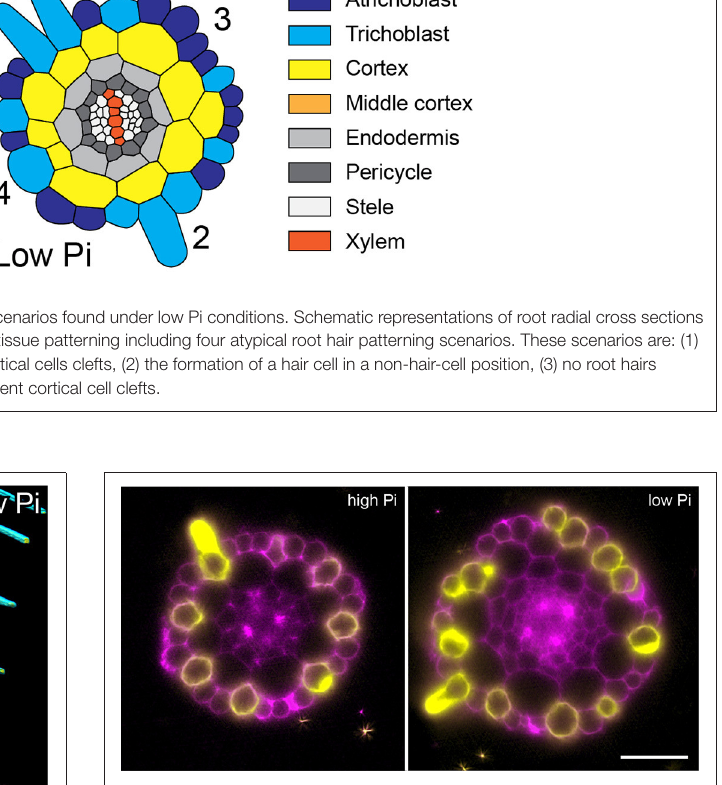
FIGURE 7 | Expression of the COBL9 marker shows atypical specification of trichoblast identity under low Pi. Anatomy of a mature part of Arabidopsis under high Pi (Left) and low Pi conditions (Right) . Multi-view recording along six directions captured using Light Sheet Fluorescence Microscopy to visualize the pCOBL9::GFP gene (yellow) and propidium iodide (magenta). Scale bars = 50 µ